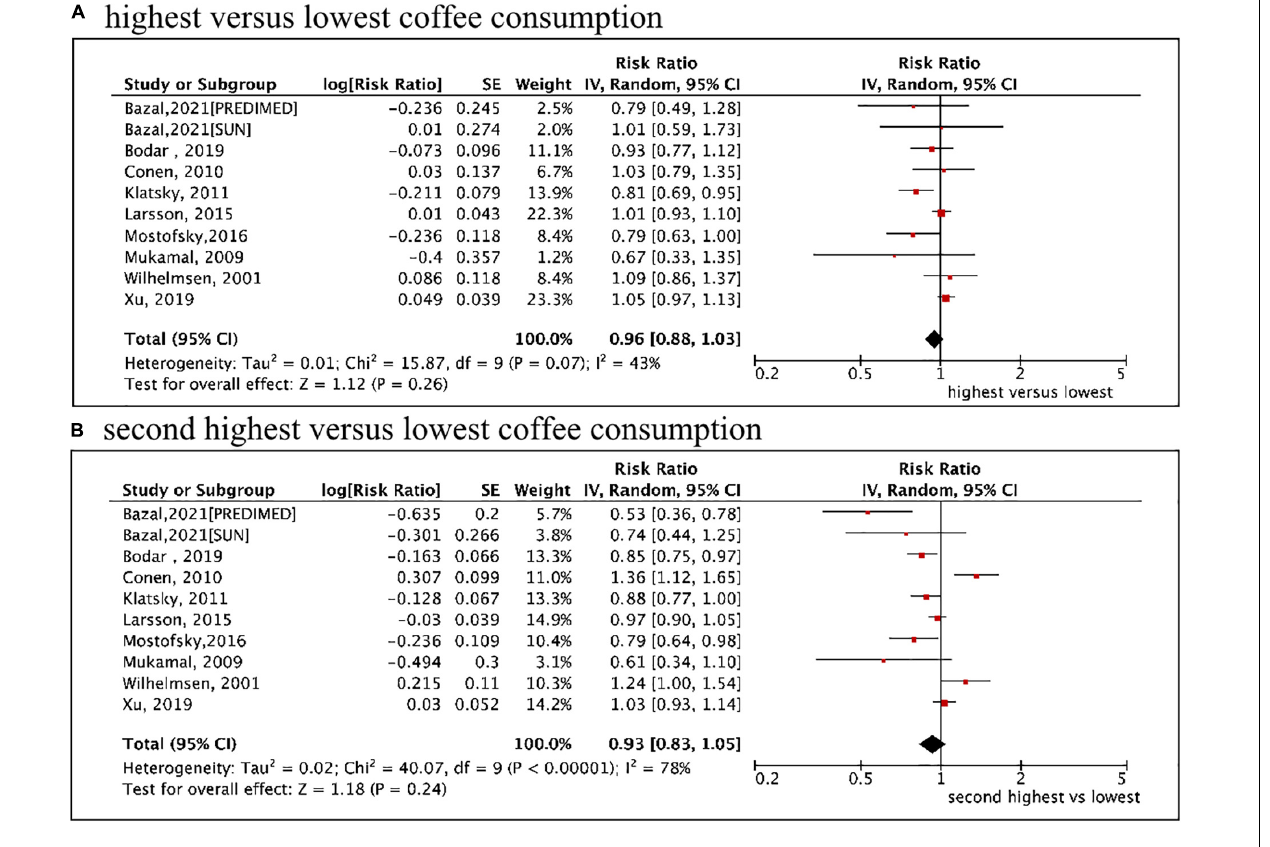
Figure 3 ) or second-highest ( P interaction = 0.42; Supplementary Figure 4 ) vs. lowest category of coffee intake with AF risk.